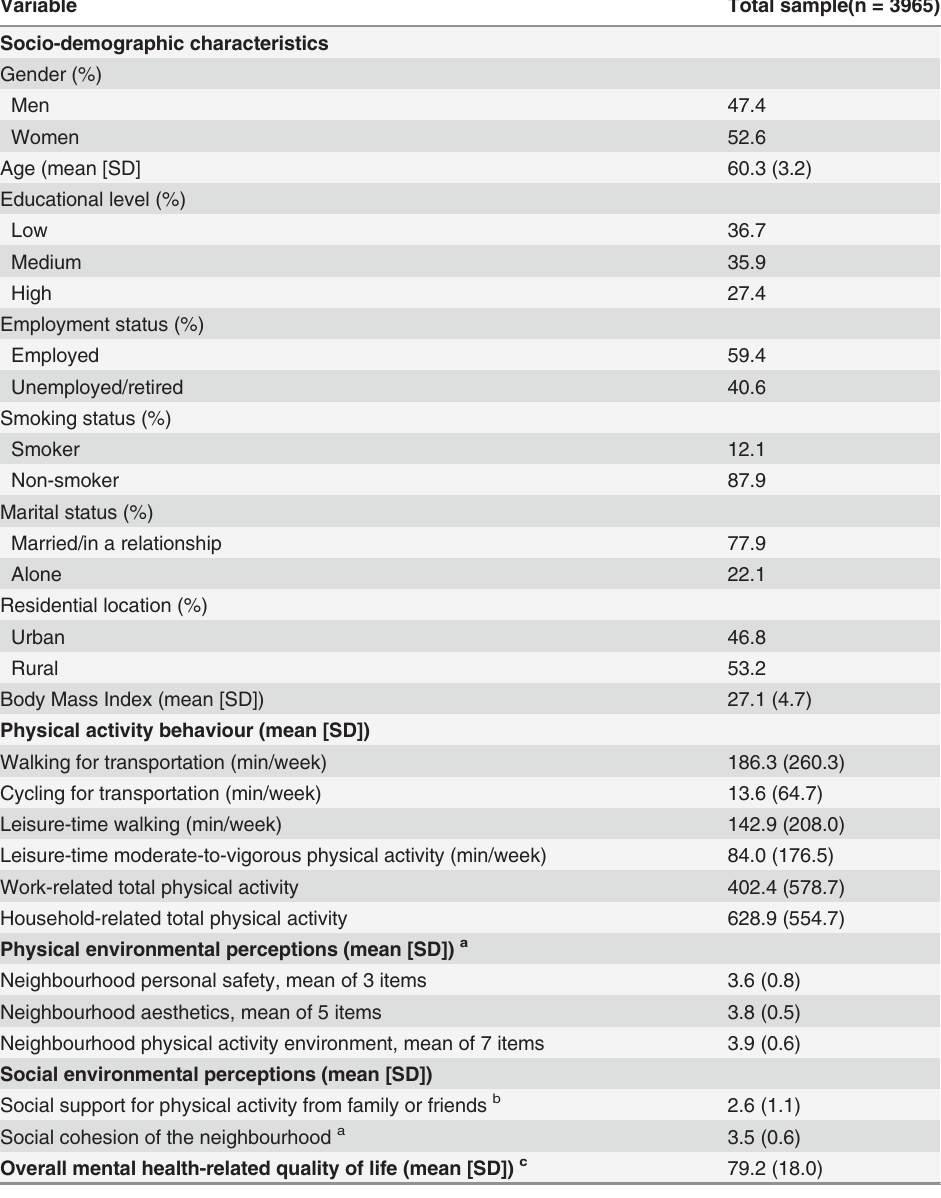
Table 1. Socio-demographic characteristics and average scores on dependent, explanatory and me- diating